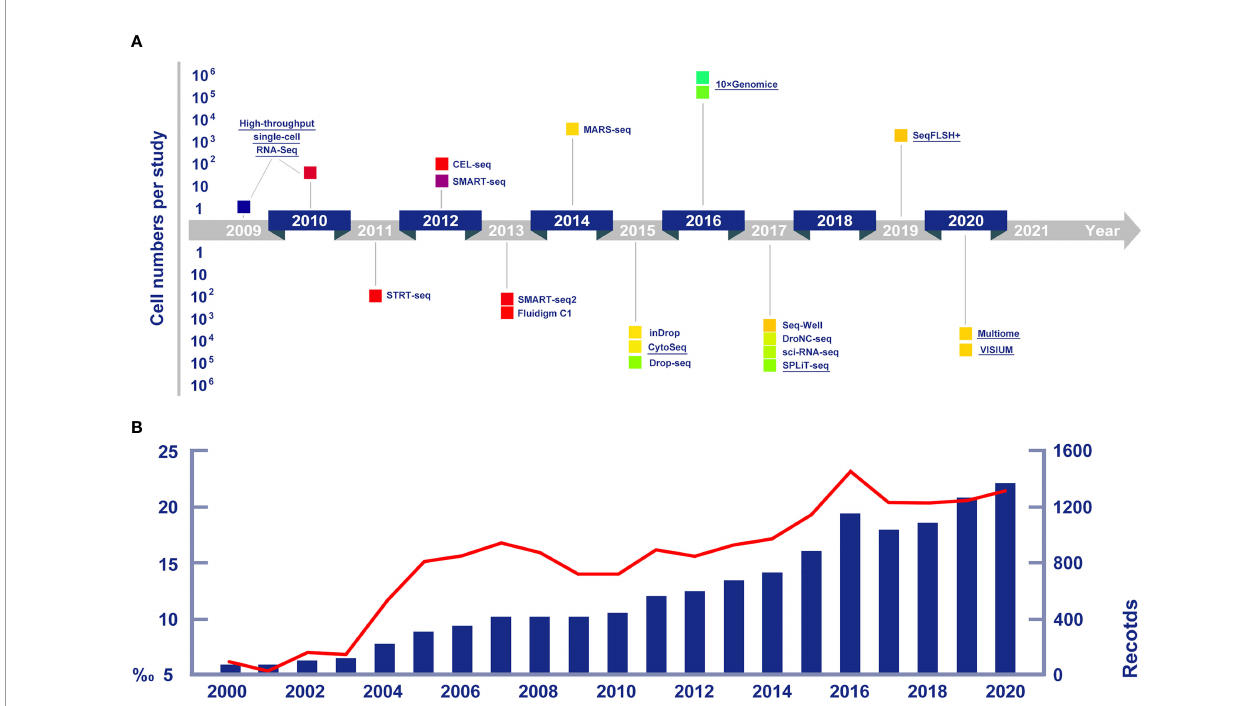
FIGURE 1 | (A) Cell numbers reported in publications and crucial single cell sequencing technologies in chronological arrangement. Technologies mentioned in detail in this article are highlighted by underlines. Data of new technologies are collected from Eng et al. (2019, seqFISH+), Bravo et al. (2020, 10x Multiome) and Longo et al. (2021, VISIUM). (B) The increasing trends of publications on marine life RNA sequencing research (the blue histogram), and the growing proportions of marine life research among all RNA sequencing studies (the red line